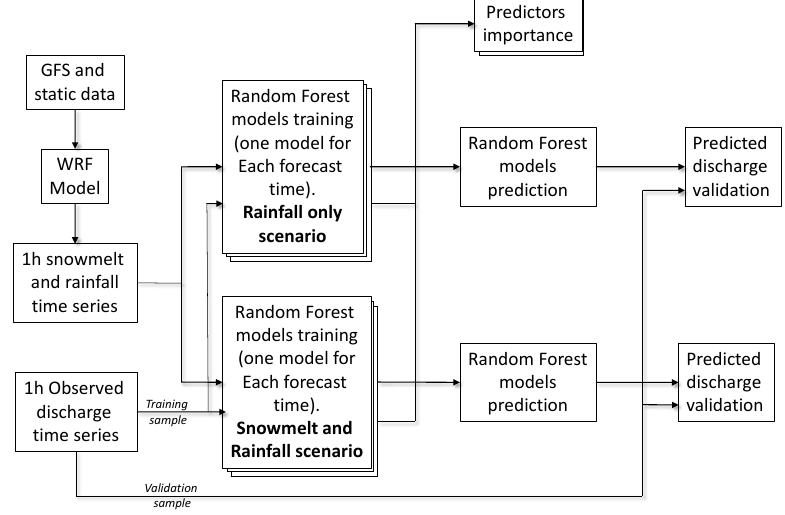
Figure 3. A flow chart presenting the experimental setup used in this